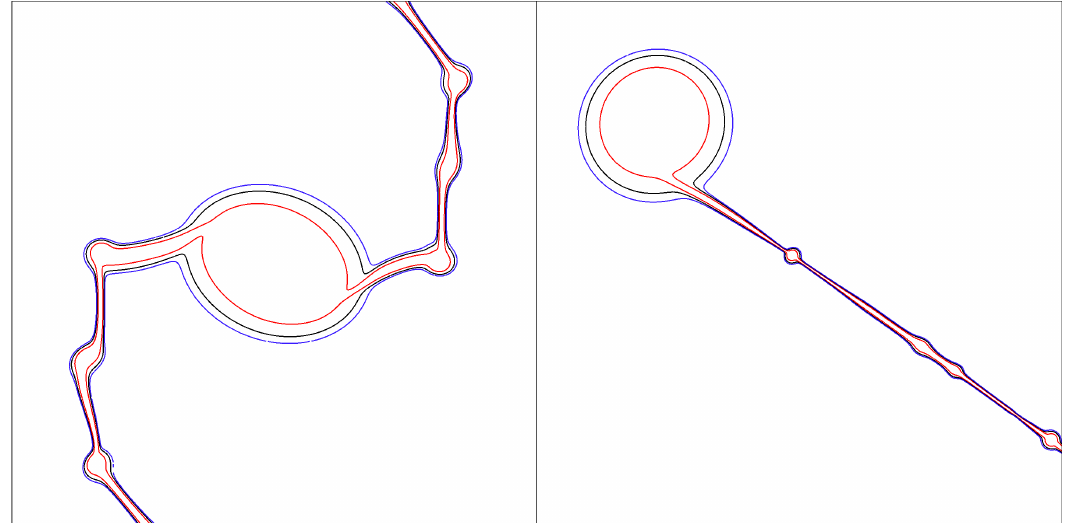
Figure 5 . Comparison of the χ = 0 . 6 (in blue), χ = 0 . 5 (in black) and χ = 0 . 3 (in red) contours for the 7 D BH collision. The χ = 0 . 6 contour tracks the AH near the neck regions. The key features of the AH are captured by all these contours; in particular, in the neck regions they are very close to each other. This effect becomes more pronounced the larger D